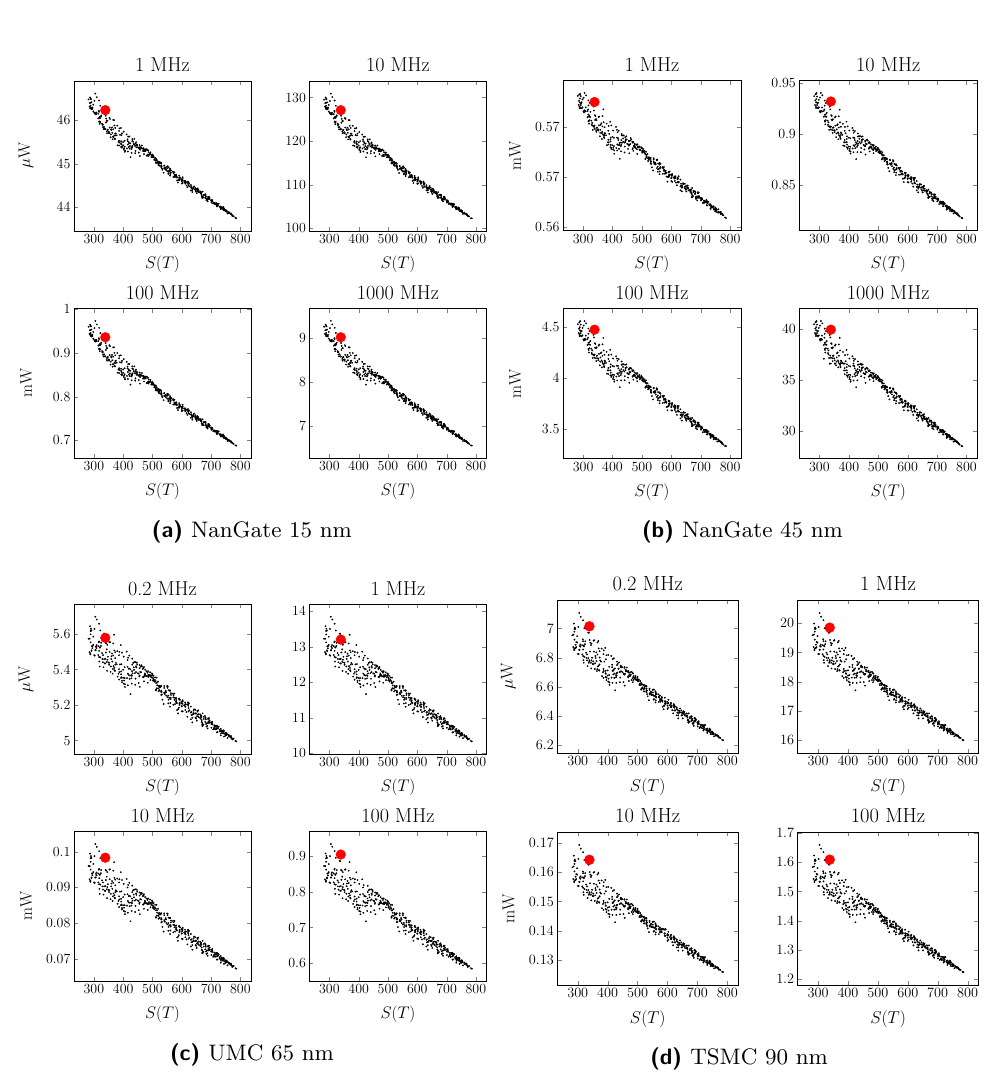
Figure 9: Power measurements of several Trivium ( X, 3) circuits vs S ( T ) for different libraries and frequencies. The red data points signify the power consumption of original Trivium